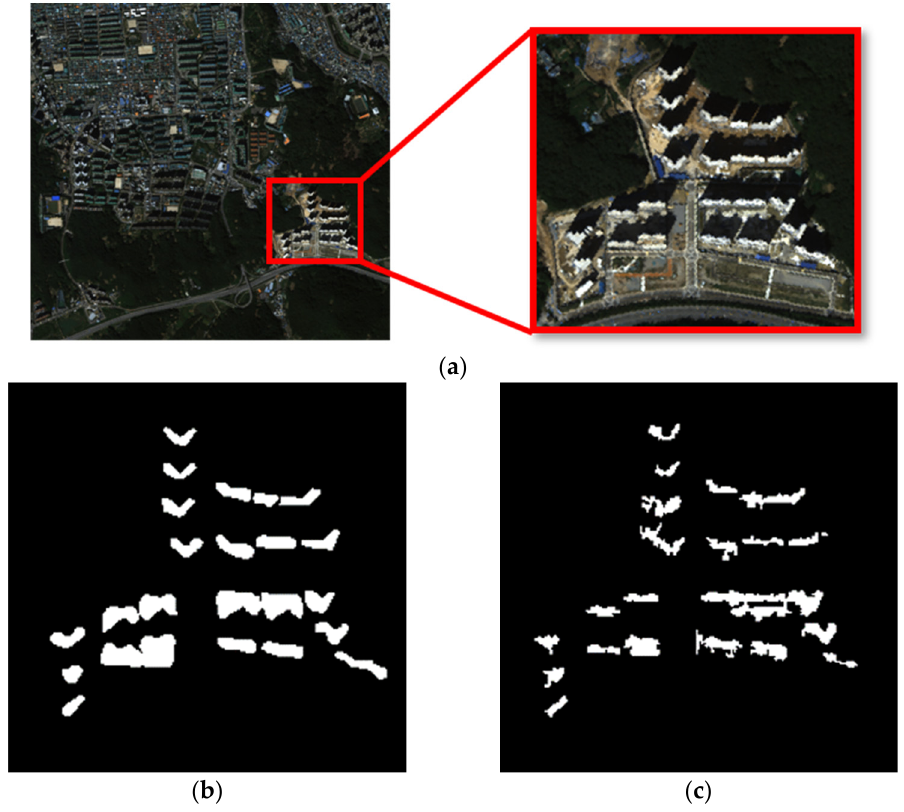
Figure 9. Example of high-rise building detection result due to incorrect segmentation. ( a ) Loca- tion in satellite image; ( b ) reference data; and ( c ) high-rise building detection result by MBI with digital maps.